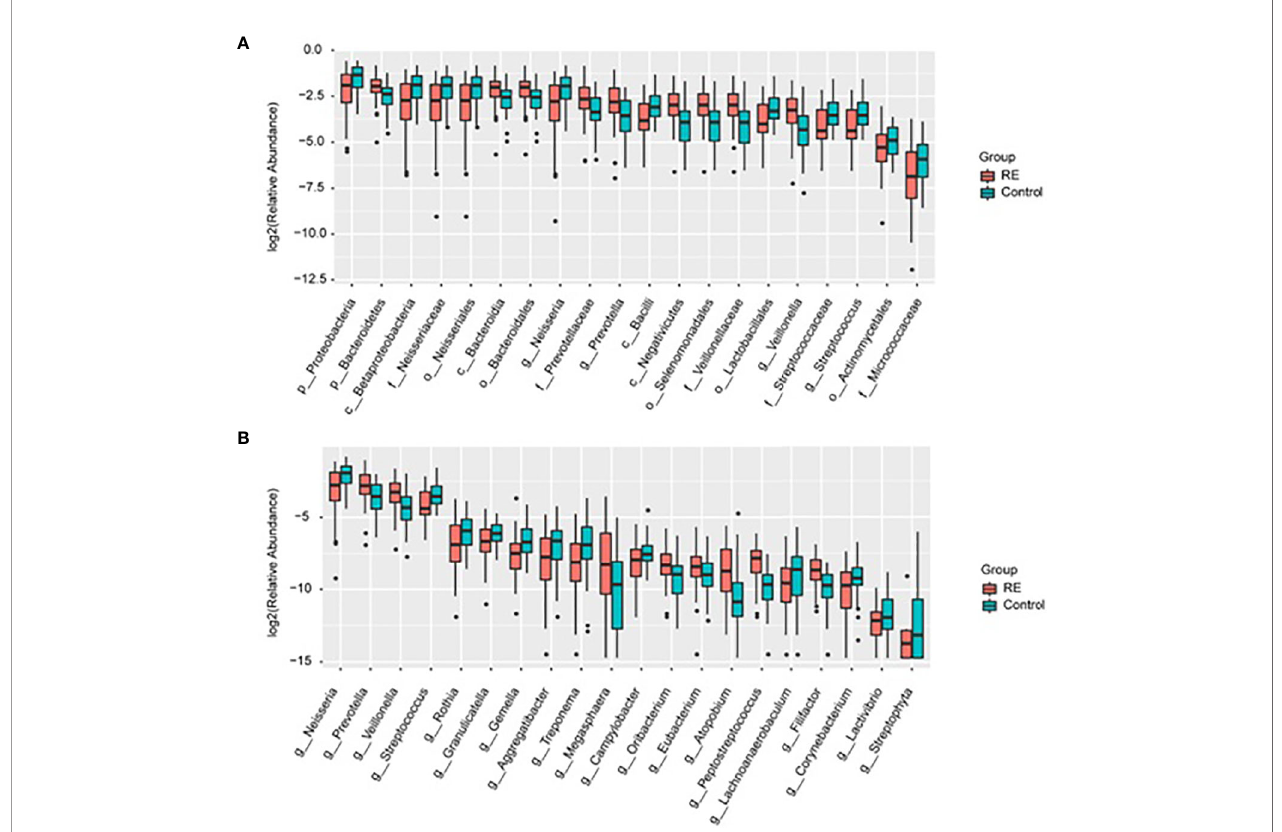
FIGURE 4 | Relative abundance of the microbial taxa between Re fl ux Esophagitis (RE) and healthy controls. Relative abundance of top 20 diversely microbial taxa (A) and microbiota structure at the general level (B) in the RE groups and the controls groups were represented by box